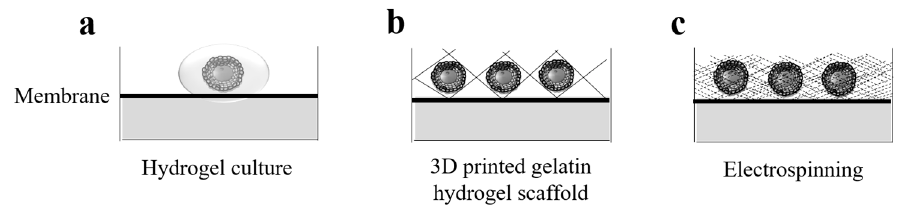
Figure 5. Comparison of the experimental design used to in vitro culture of secondary follicles. ( a ) Isolated secondary follicles are transferred in drops of hydrogels (alginate—Matrigel ® ) on a polypropylene mesh (100 µm). Then, the mesh is immerged into encapsulation solution. ( b ) Bioprinted scaffold (gelatin) has struts of ~350 µm and pore size of ~350 µm; angles are 30° or 60°. Secondary follicles are seeded onto scaffold and cultured. Contacts with scaffold and follicles are limited. ( c ) Electrospinning technique produces fibrous scaffold of poly ( ε -caprolactone) and gelatin. Average fiber diameter: 495 ± 133 µm. Follicles are adherent on the entire bio-structure.